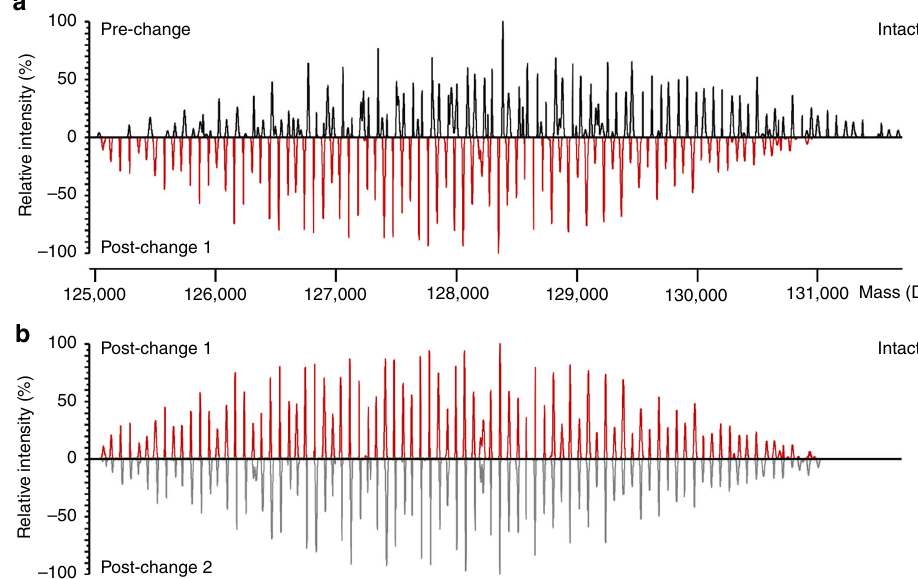
Fig. 5 Comparison of pre- and post-change batches of Enbrel ® upon native mass spectrometry at the intact protein level. a Mirror plot of deconvoluted mass spectra of Enbrel ® EU pre- and post-change batch 1. b Mirror plot of deconvoluted mass spectra of Enbrel ® EU post-change batches 1 and 2. Spectra were acquired at R set = 35,000 at m/z 200. Mass spectra were acquired with identical instrument settings (SID 100 eV; CE 25